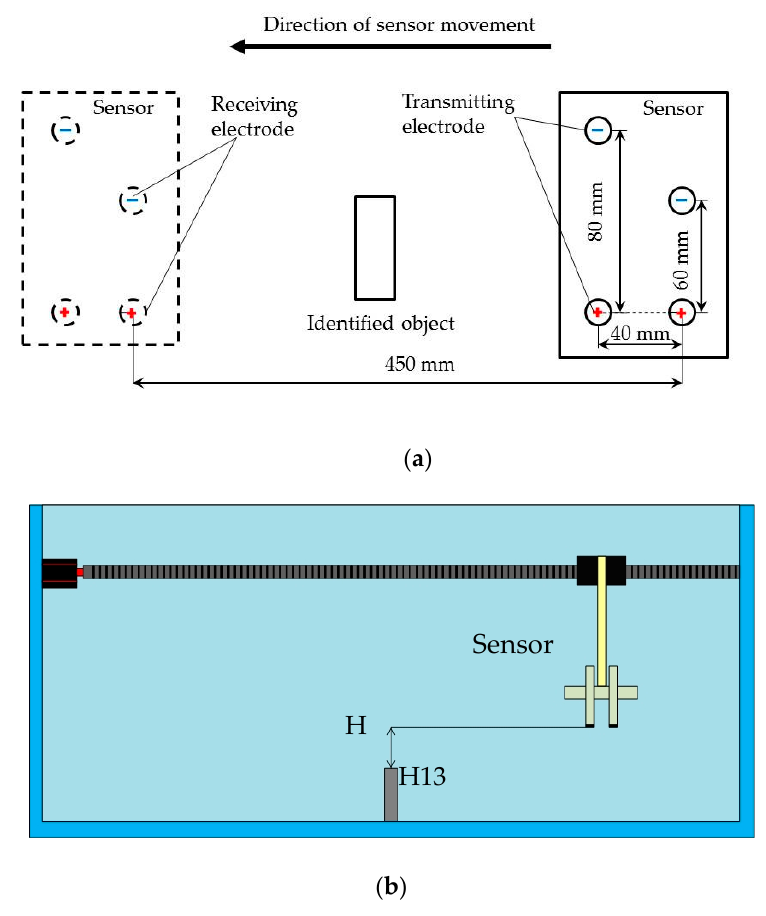
Figure 3. ( a ) Schematic of sensor identifying underwater objects; ( b ) Schematic of sensor’s movement underwater. H: Height of identification.